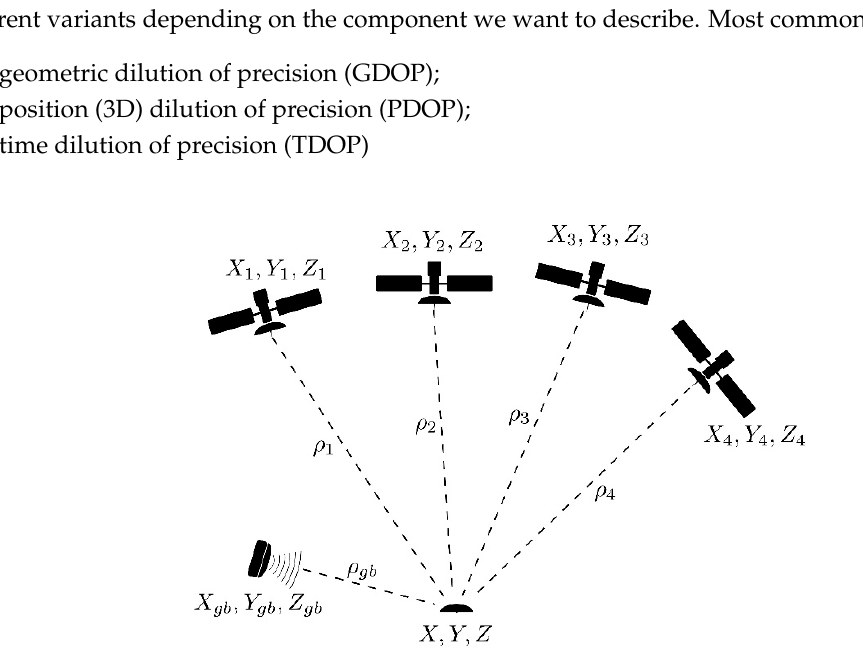
Figure 1. Geometry of Global Navigation Satellite Systems (GNSS) single point positioning with additional ground-based augmentation.